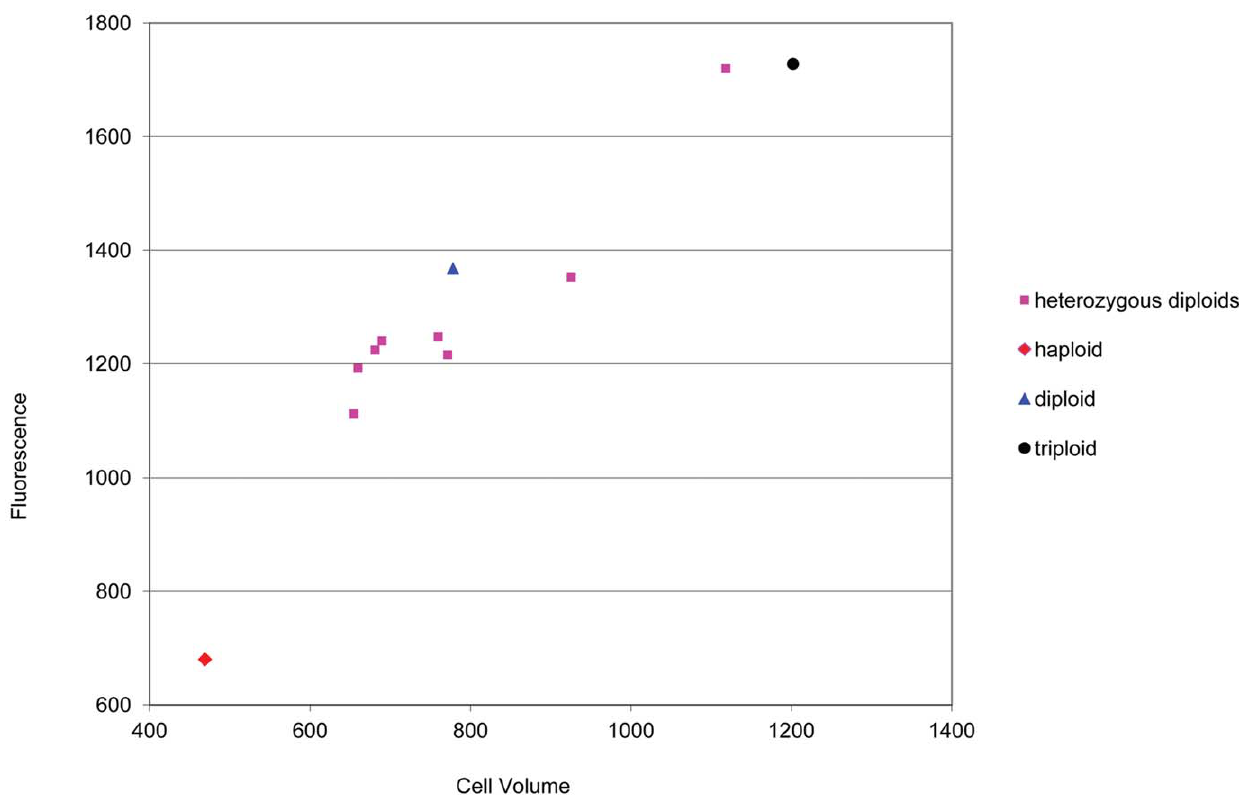
Figure 6. Levels of protein from hml::YFP reporter increase with cell size. Diploid strains with a range of cell size were created by mating appropriate strains from the haploid Yeast Deletion Collection [19] to the haploid strain containing the hml::YFP reporter. YFP levels were measured by flow cytometry in these strains (pink squares) and in haploid (red diamond), diploid (blue triangle) and triploid (black circle) strains. Mode fluorescence was plotted versus cell volume in m m 3 (measured by microscopy).